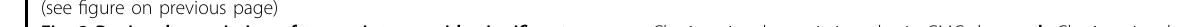
Fig. 2 Regional association of transcriptome-wide signi fi cant genes. a Chr 1 regional association plot in CMC dataset. b Chr 1 regional association plot in BrainSeq2 dataset. Of note, TCTEX1D1 driven the association signal in both two eQTL datasets. c Chr 3 regional association plot in CMC dataset. d Chr 3 regional association plot in BrainSeq2 dataset. e Chr 11 regional association plot in CMC dataset. f Chr 11 regional association plot in BrainSeq2 dataset. Notably, FADS1 explained most of the association signal in both two eQTL datasets. g Chr 13 regional association plot in CMC dataset. h Chr 13 regional association plot in BrainSeq2 dataset. Notably, B3GALTL driven the association signal in both two eQTL datasets. i Chr 22 regional association plot in CMC dataset. j Chr 22 regional association plot in BrainSeq2 dataset. Notably, XPNPEP3 explained most of the association signal in both two eQTL datasets. The top panel in each plot shows all of the genes in the locus. The marginally TWAS associated genes are highlighted in blue, and those that are jointly signi fi cant highlighted in green. The bottom panel shows a Manhattan plot of the GWAS data before (grey) and after (blue) conditioning on the predicted expression of the green genes. The x -axis denotes genome coordinates and the y -axis denotes association P -values in GWAS.